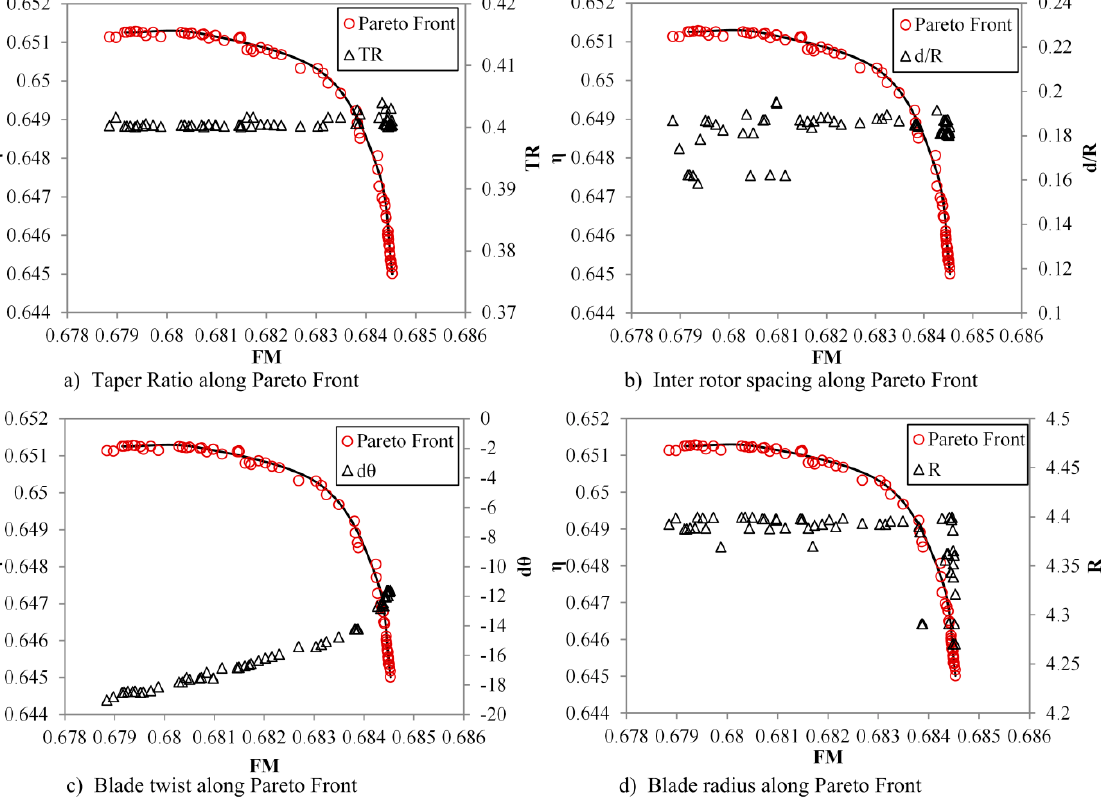
Figure 15. Parameters along the Pareto front in multi-objective optimization.